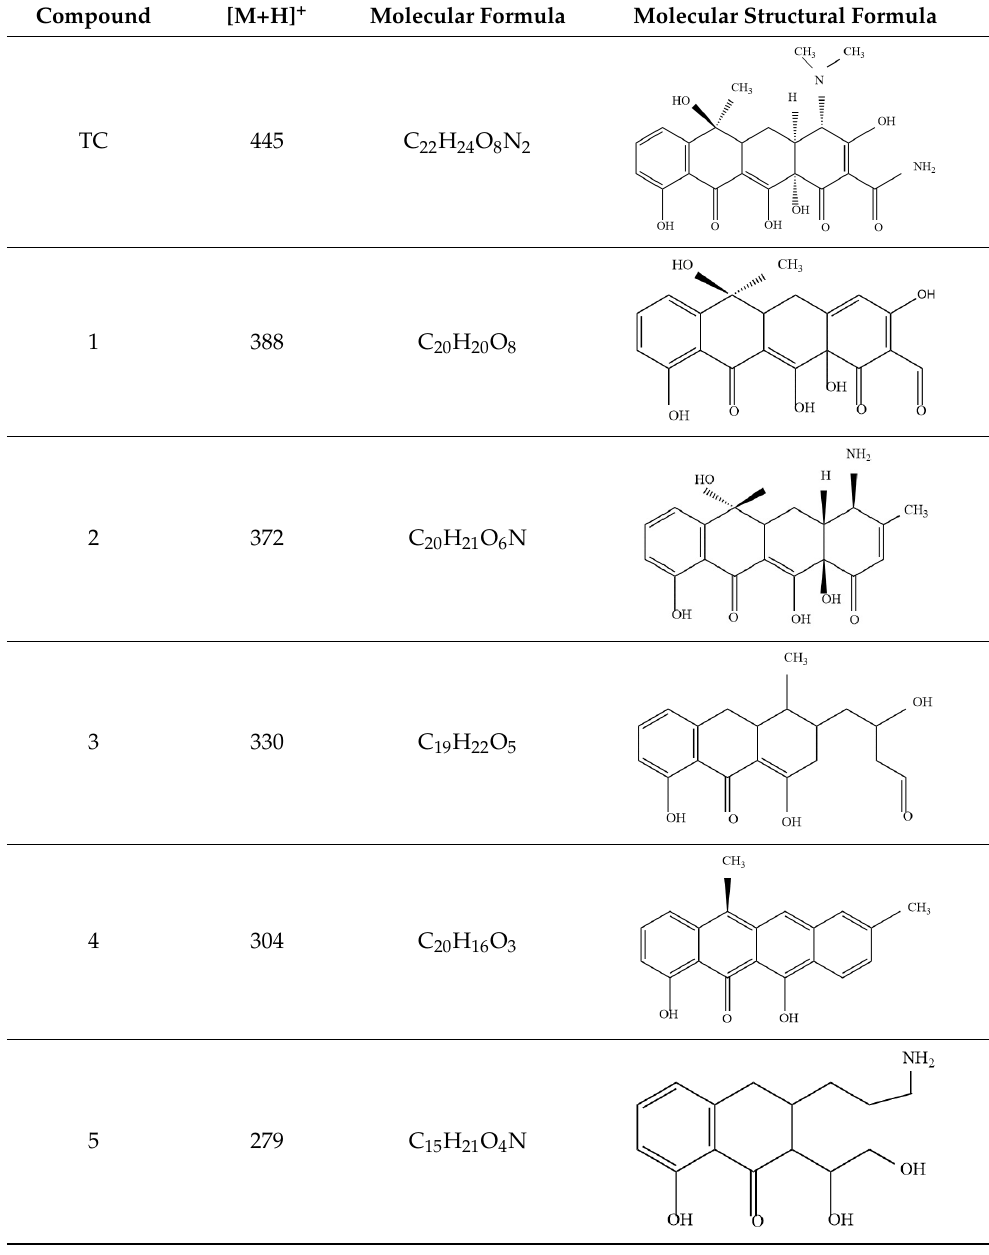
Table 2. Intermediate determined in the degradation of TC by ZnO‐C/MnO 2 .